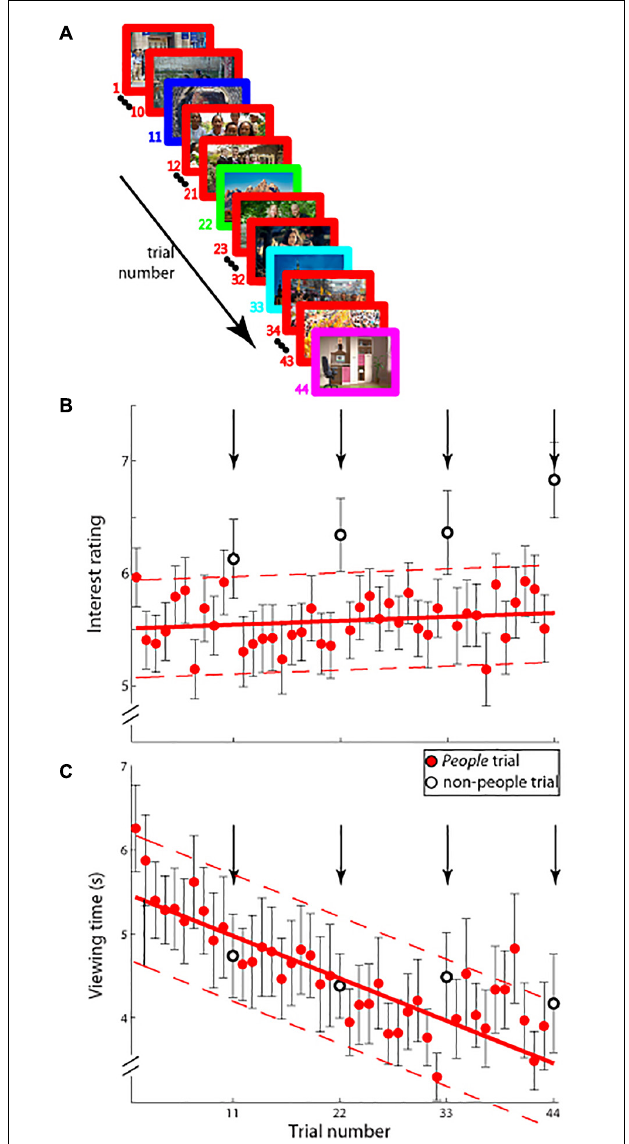
FIGURE 2 | (A) Schematic of experimental paradigm (Experiment 2A). On each trial (44 trials total), an image was displayed on the screen and observers viewed it for as long as they desired. Interest ratings were obtained as in Experiment 1. Images from people were shown on all trials (red border) except on trial numbers 11, 22, 33, and 44 (borders not colored red), on which images from one of the remaining four categories was shown. (B) Interest ratings on a ten-point scale (mean ± SEM.; ordinate) and (C) viewing time in seconds; (mean ± SEM; ordinate) as a function of trial number (abscissa) are shown. Group people trial data (solid red circles) were fitted with a least-squares linear function (solid red lines) and its 95% confidence interval (dashed red lines). Trial numbers 11, 22, 33, and 44 are shown in open circles and arrows, and were not used in determining the fit.